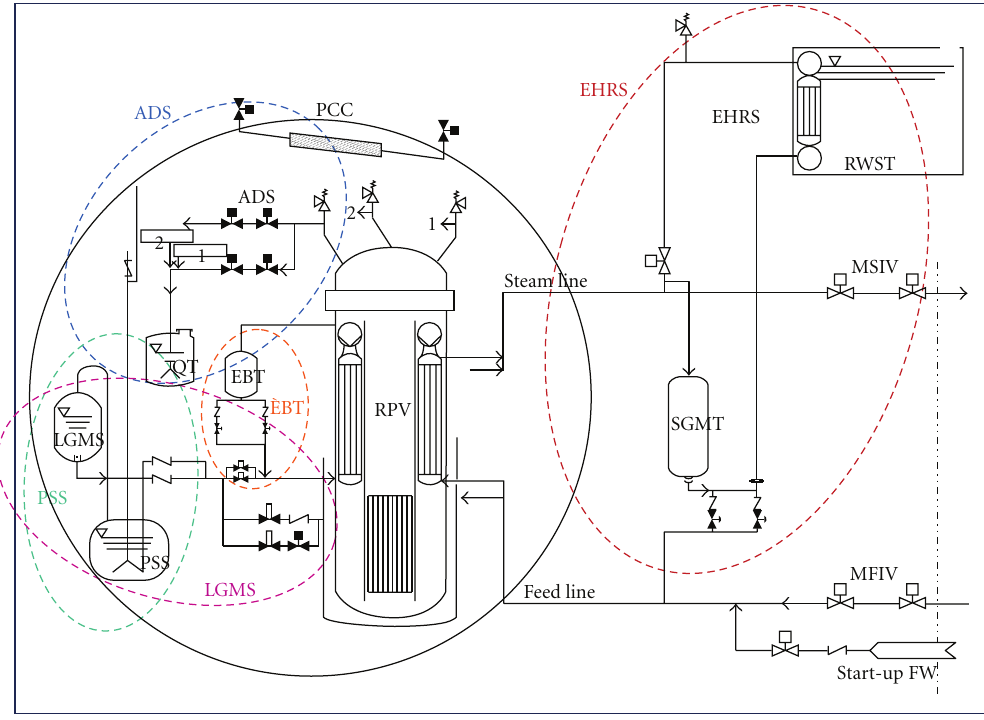
Figure 2: IRIS spherical containment and safety